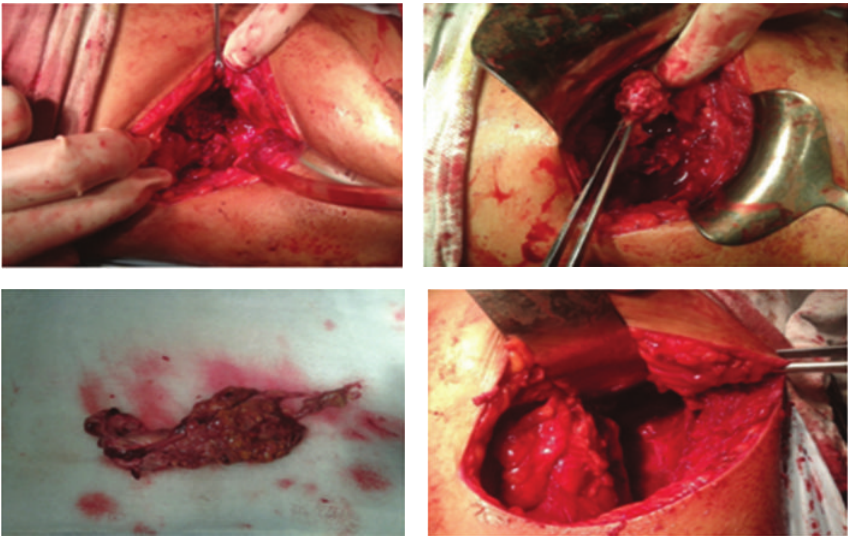
Figure 2: Intra operative pictures showing necrotic renal tissues.